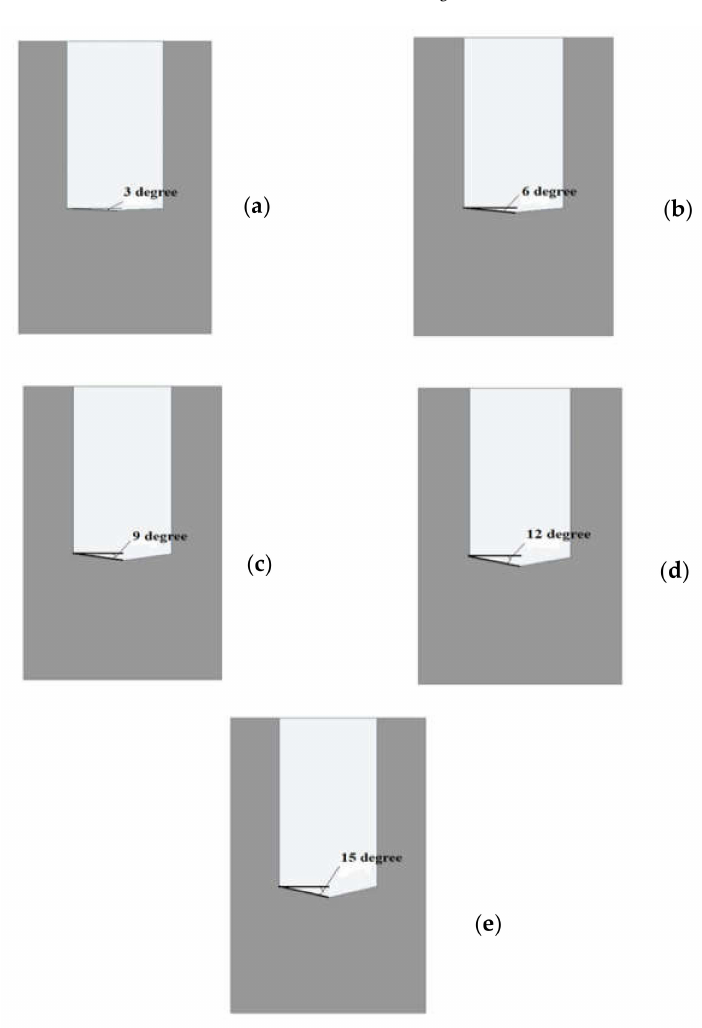
Figure 2. Two sided wedge shape in microchannel (cross-sectional view): angle ( a ) 3 ◦ , ( b ) 6 ◦ , ( c ) 9 ◦ , ( d ) 12 ◦ , ( e ) 15 ◦